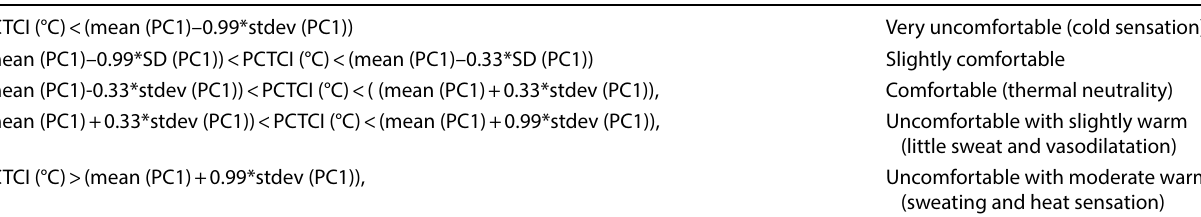
Table 6 PCTCI cognitive